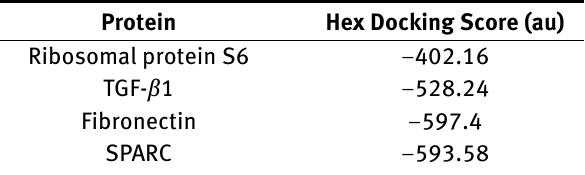
Table 4: The binding scores obtained from the molecular docking studies for the interaction of HA 001 crystal plane with the various proteins in the different stages of the cell growth